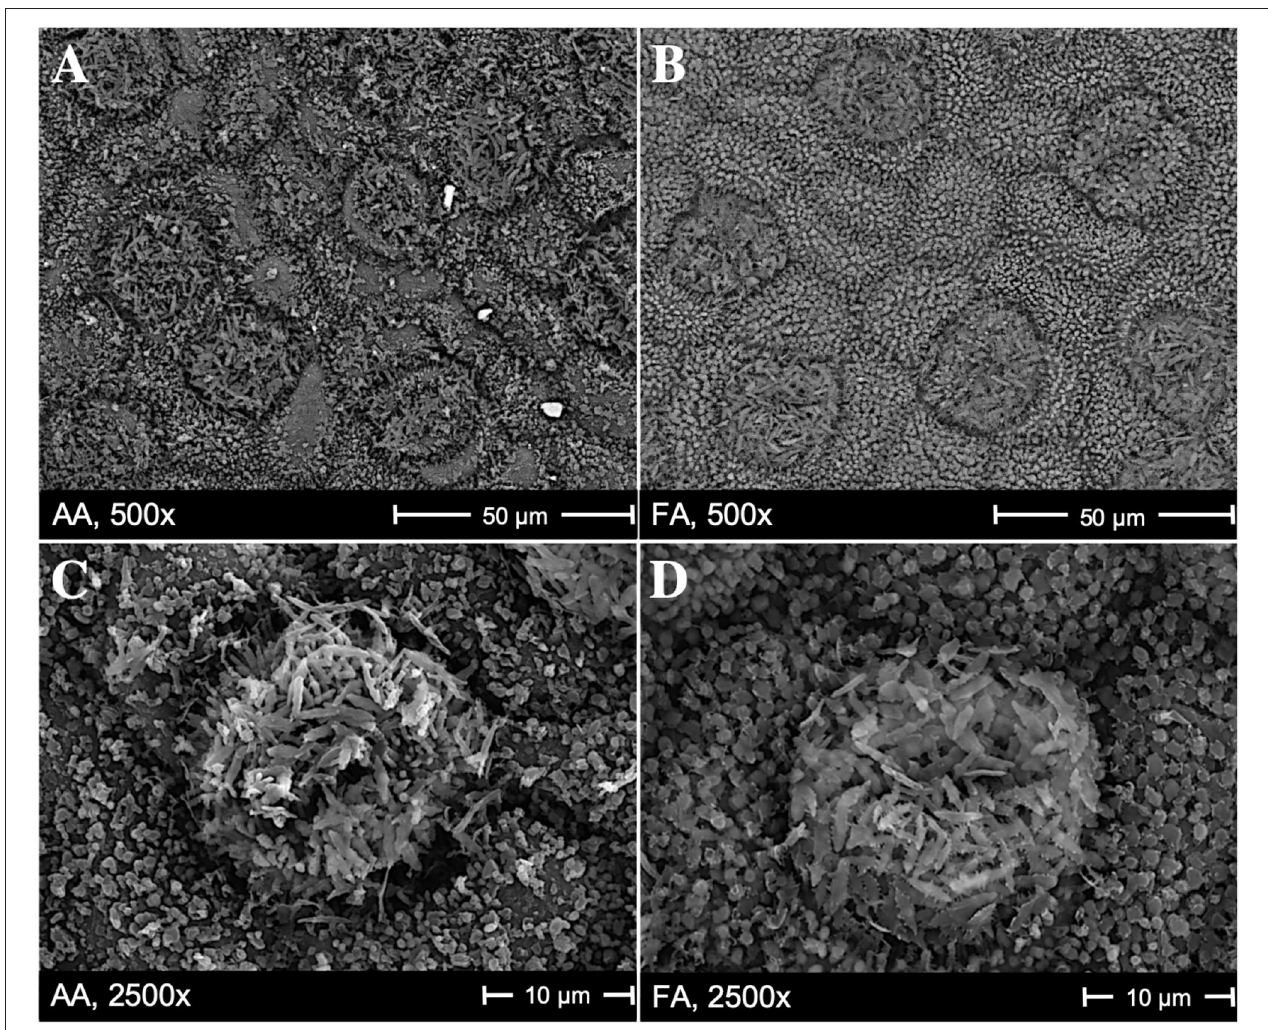
FIGURE 1 | Scanning electron microscopy images showing the stomata patterns on the abaxial surface of Cinnamomum camphora , with magnification 500x and 2,500x. (A,C) are from AA leaves (the greenhouse with ambient air) and (B,D) are from FA leaves (the greenhouse with filtered air). Flat, amorphous areas in (A,C) are probably caused by deliquescent, hygroscopic aerosols. Such an area is, e.g., in (A) above the left part of the 50 µ m